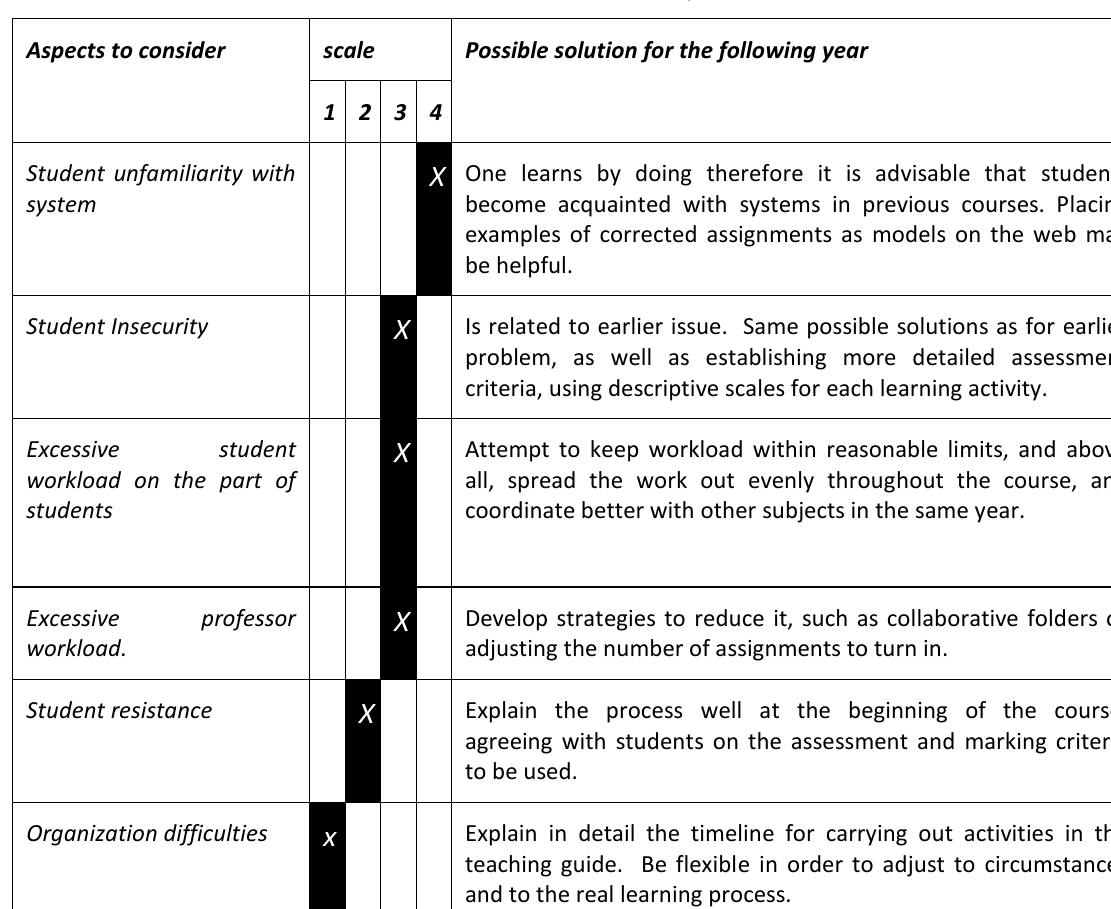
Table 4: Problems, weaknesses, and possible